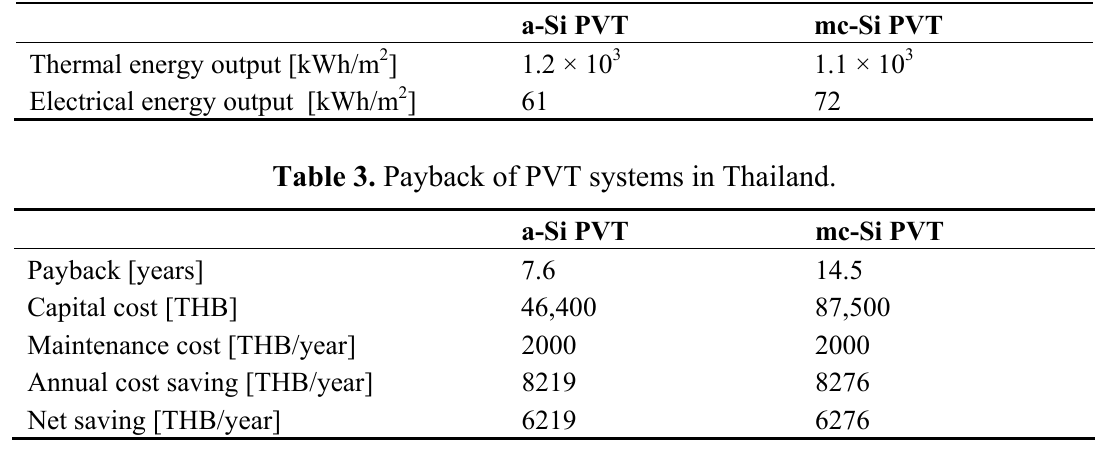
Table 2. The annual energy output of PVT collectors.